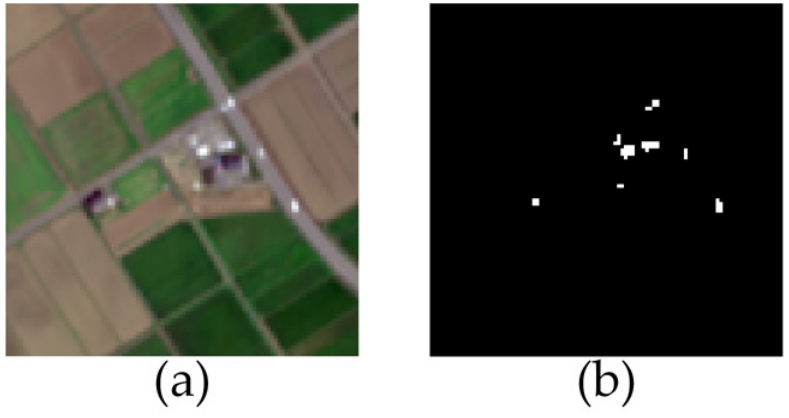
Figure 6. Chikusei dataset: ( a ) false–color map of the Chikusei dataset; ( b ) ground truth map.